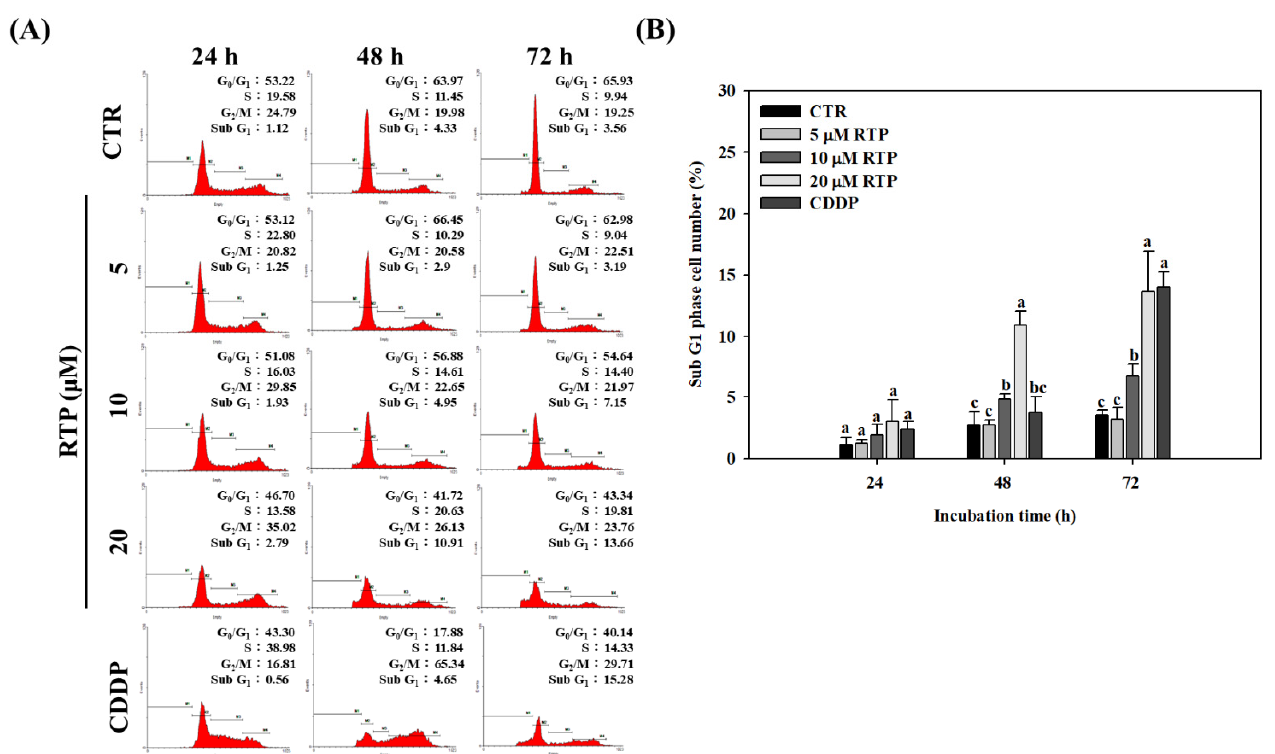
Figure 2. Effects of rutaecarpine (RTP) on cell cycle progression in human esophageal squamous cells CE81T/VGH. Cells (1 × 10 5 cells/mL) were treated with RTP (5, 10, and 20 μ M) or cisplatin (CDDP; 5 μ M) for 24, 48, and 72 h. ( A ): Cell cycle distributions were measured using flow cytometry. ( B ): Percentages of sub-G1 cells in Figure 2A. CTR represents the control group. Values (means ± SD, n = 3) within the same time interval not sharing a common lower case letter are significantly different from one another ( p < 0.05).